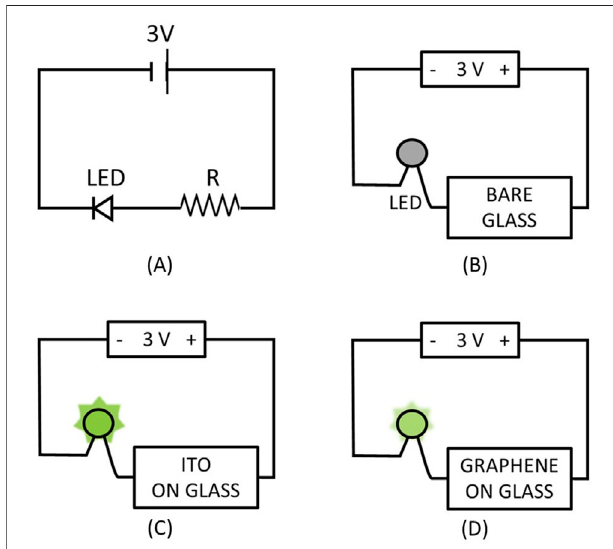
FIGURE 1 | Circuit scheme of the experiment on ITO substitution in transparent conductive coatings. (A) Switching on a light emitting diode (LED) inserted in a circuit made up of the LED itself, one battery, and one resistor. (B – D) The resistor is presented in the form of a glass platelet either uncoated (B) or coated with transparent conductive layers of different materials (C,D) . The light turns on only when the glass is coated by ITO (C) or graphene (D)